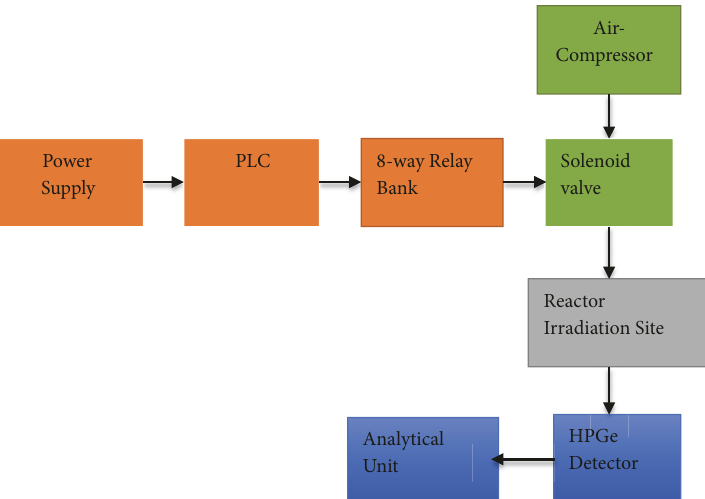
Figure 3: A complete block diagram of pneumatic transfer system (PTS) of the